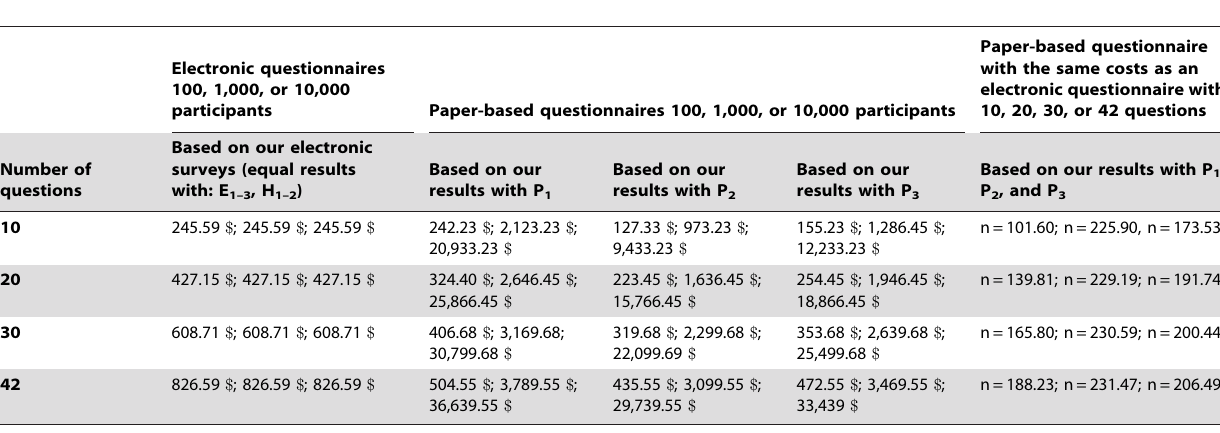
Table 5. Estimated costs for electronic and paper-based questionnaires with 10, 20, 30, or 42 questions and different cohort